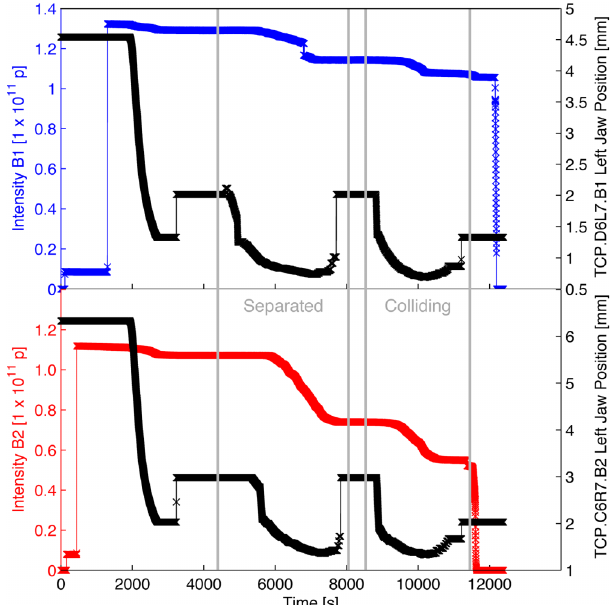
FIG. 3. The beam intensities and the left jaw collimator posi- tions as a function of time ( t ½ 0 (cid:3) ¼ 22 : 06 : 2012 , 04:30:00). Scraping with the left jaws of the TCP.D6L7.B1 (vertical plane) and TCP.C6R7.B2 (horizontal plane) was performed with squeezed noncolliding and colliding beams.